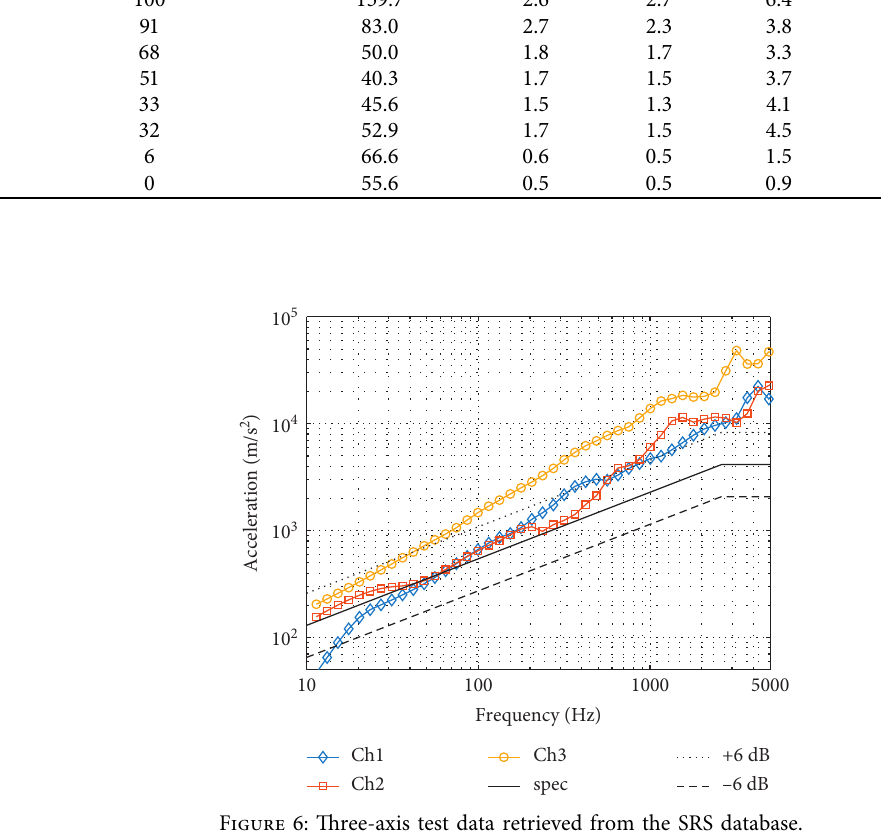
Table 5: Comparison of different methods of database SRS retrieval (SRS octave spacing � 1/12). SRS no.